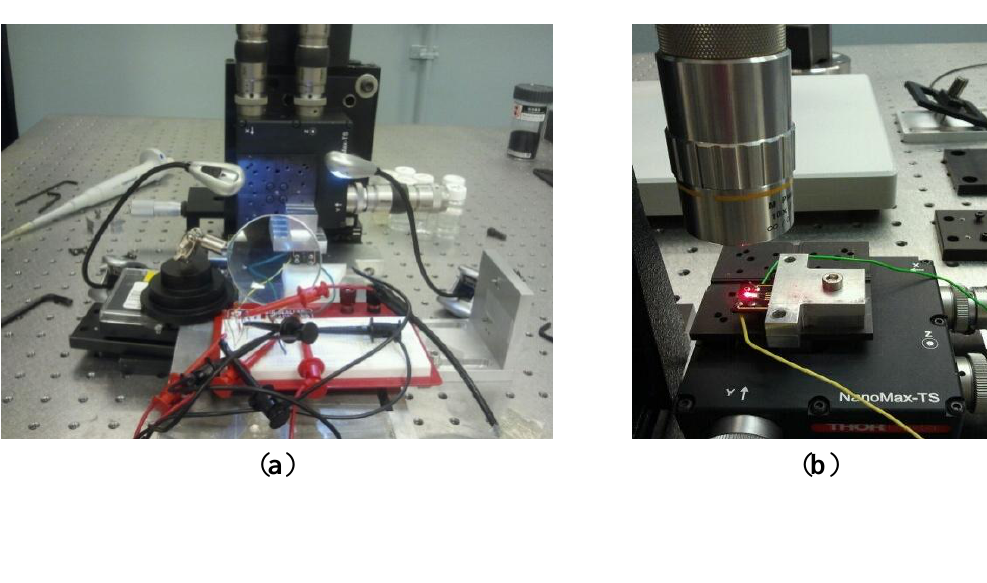
Figure 9. Veeco Active Probe mounted on a holder ( a ) connected to the pure capacitive bridge for self-sensing implementation, ( b ) placed under laser vibrometer